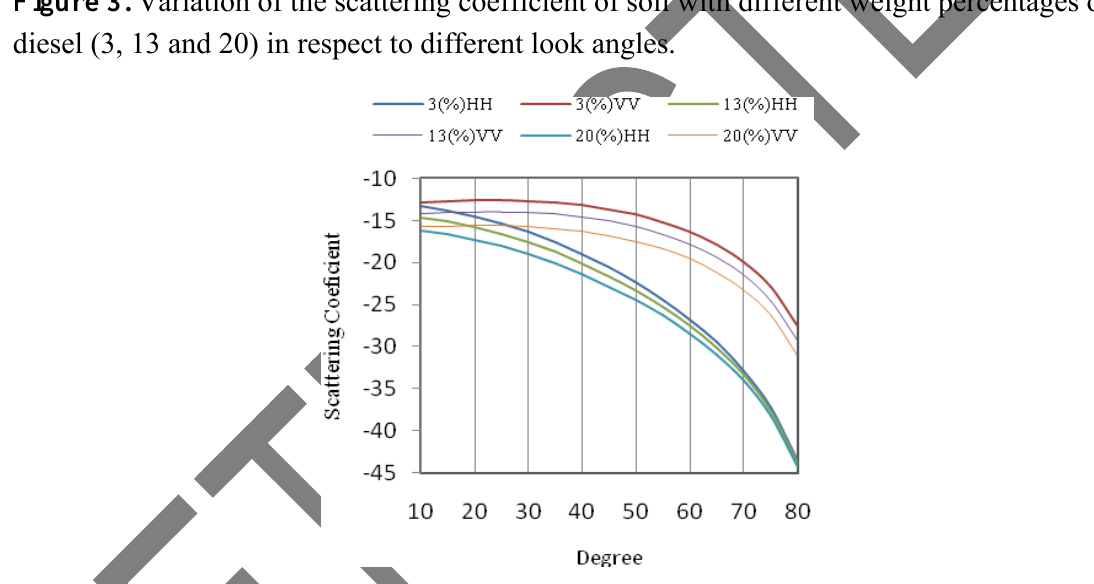
Figure 4. Variation of the scattering coefficient of soil with different weight percentages of diesel (7, 9 and 16) in respect to different look